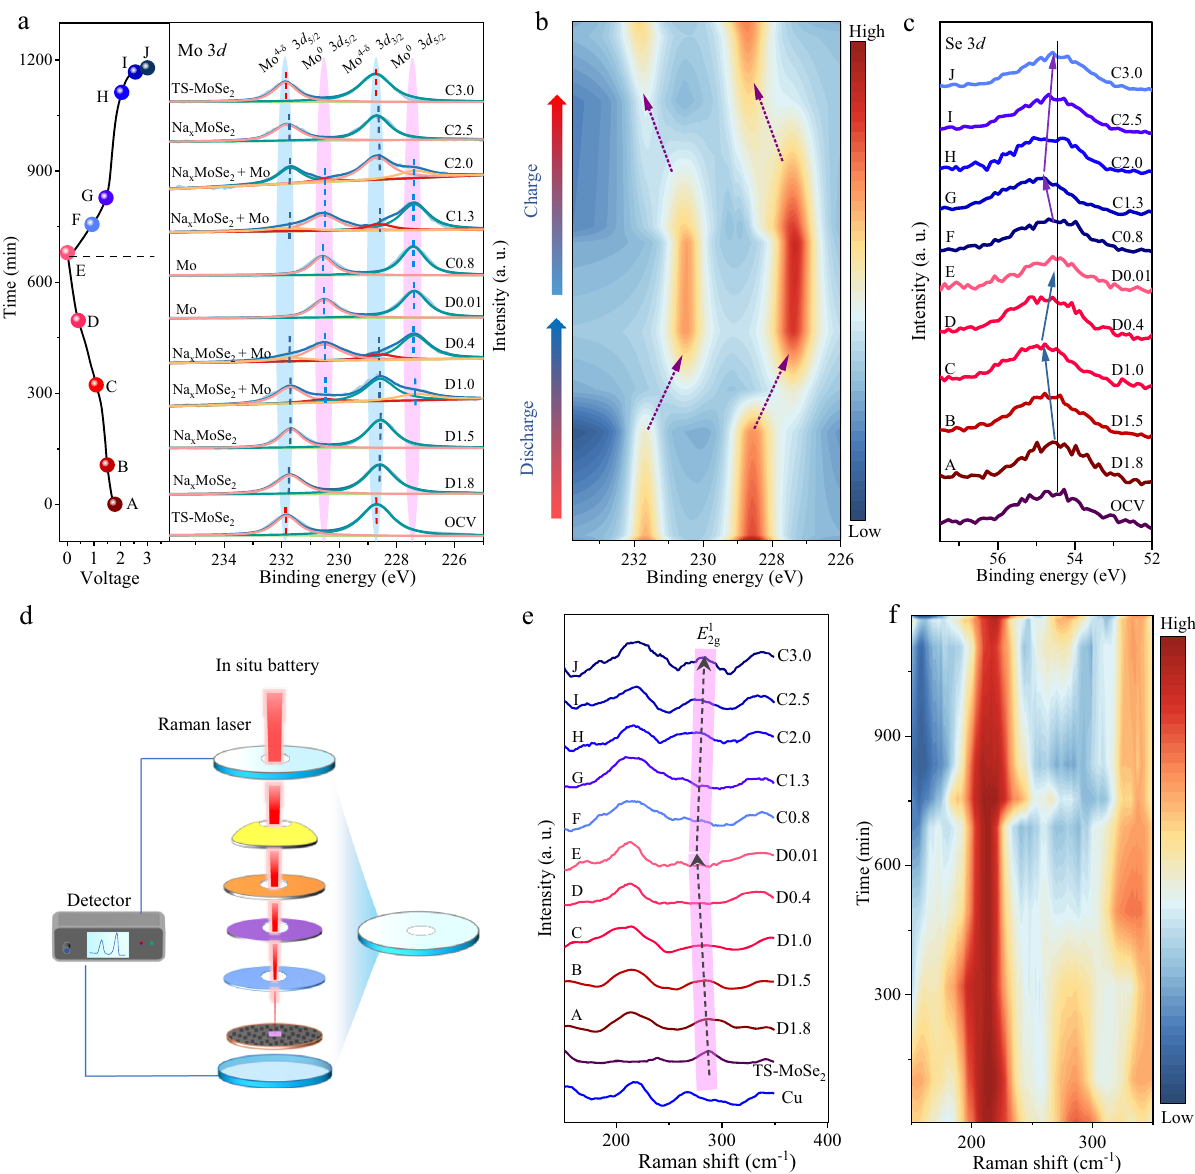
Fig. 3 | Study on discharging and charging processes based onex situXPS and in situ Raman spectra. a – c ex situ Mo 3 d XPS spectra ( a ) and corresponding mapping image( b ), as well as Se 3 d XPS spectra ( c ) of TS-MoSe 2 during the initial